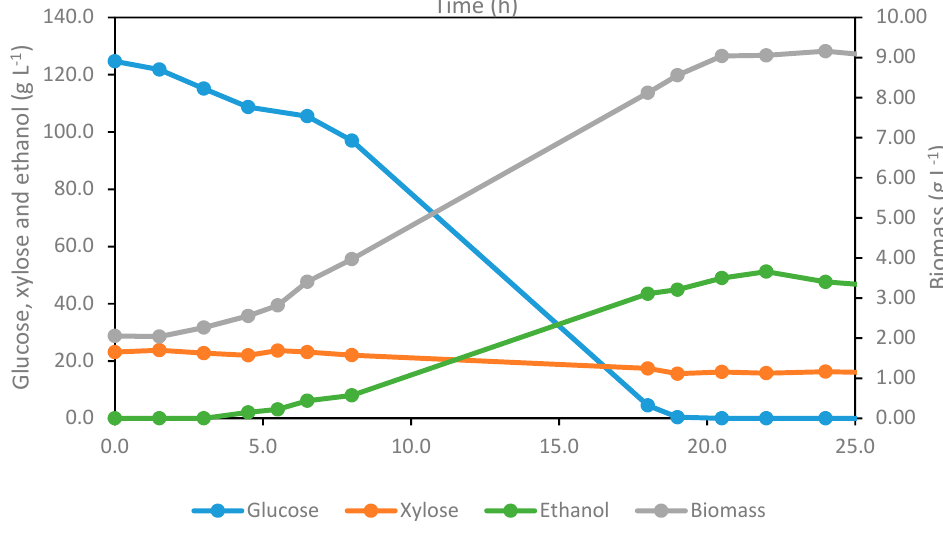
Figure 4. Profile of glucose, xylose, ethanol and biomass for Ethanol Red ® fermentation (2 L, 180 rpm, and 28 °C, pH 5.5).